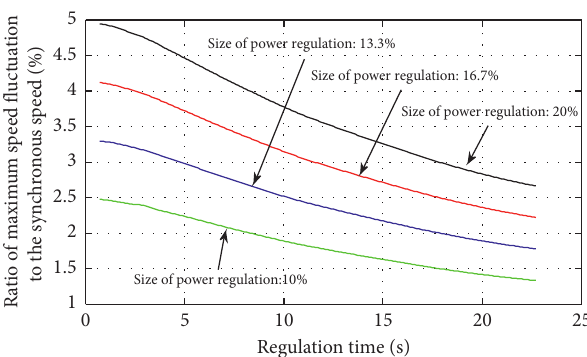
Figure 20: Effect of the power control closed-loop response time on the speed.